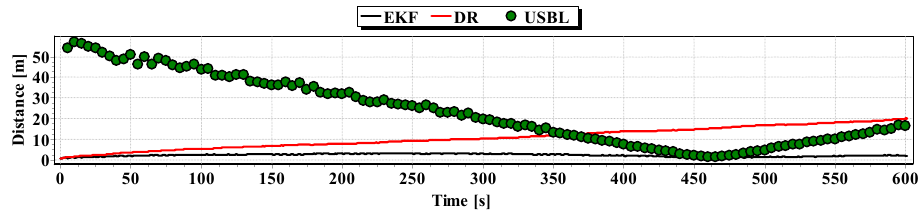
Figure 18. Graph of the reference position distance from the position estimated by EKF and DR methods and determined by the USBL system (one hundred passages).